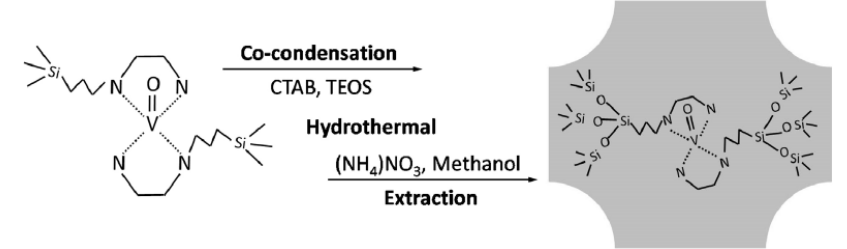
Figure 9. The schematic representation of the synthesis of V-PMO materials.